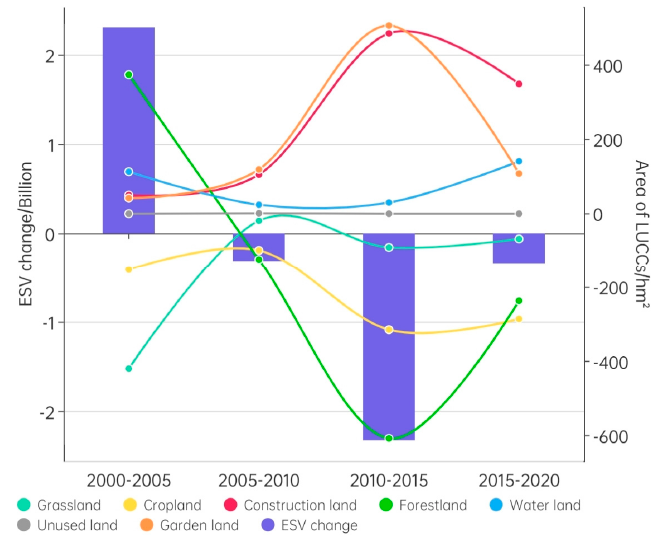
Figure 3. Land-use change and ESV in the Wuling Mountains from Figure 3. Land ‐ use change and ESV in the Wuling Mountains from 2000–2020.